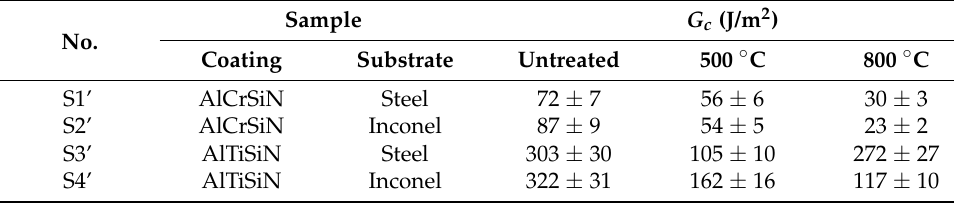
Table 7. Critical load and adhesion energy of the coated systems after thermal